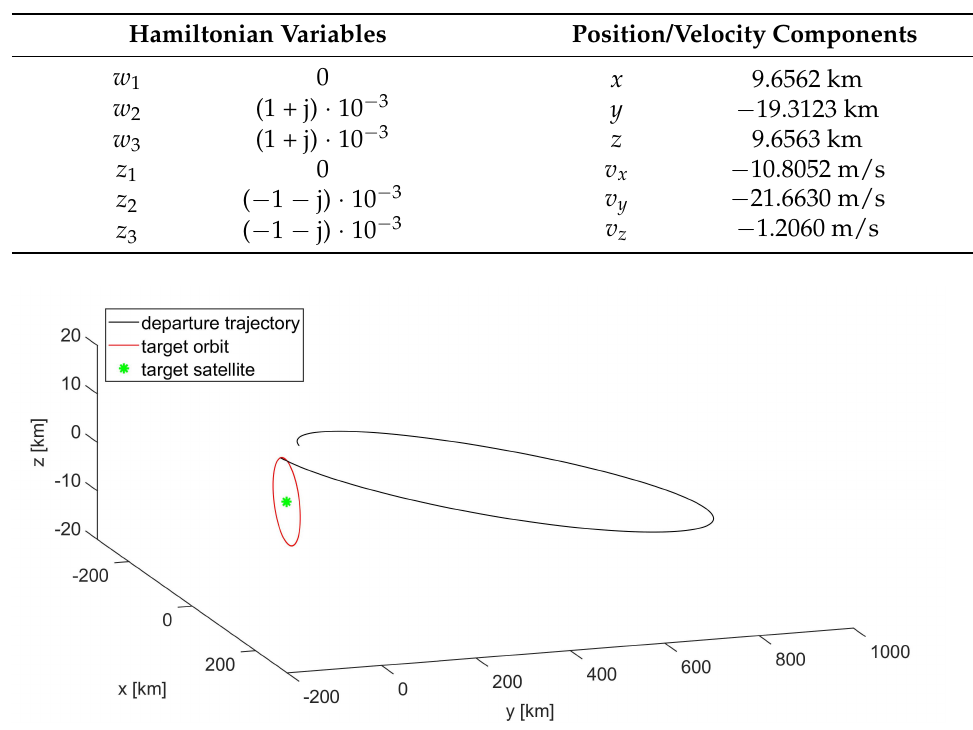
Figure 14. Guidance strategy: transfer of the reconnaissance satellite into a J n -invariant bounded trajectory in F r about the target